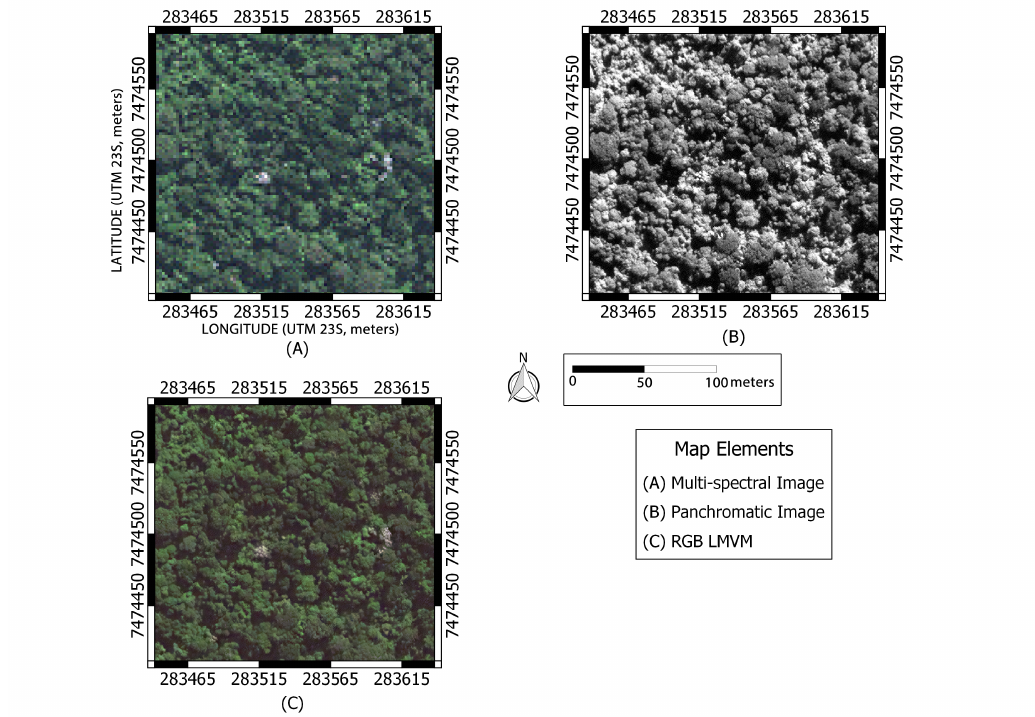
Figure 2. ( A ) The multi-spectral image obtained from the composition of R, G, B spectral bands with spatial resolution of 2.0 m; ( B ) The panchromatic image with spatial resolution of 0.5 m; ( C ) The image obtained from pan-sharpening process by the LMVM